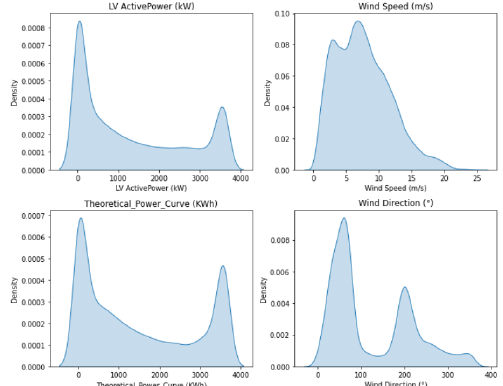
Figure 2. Distribution of column values.